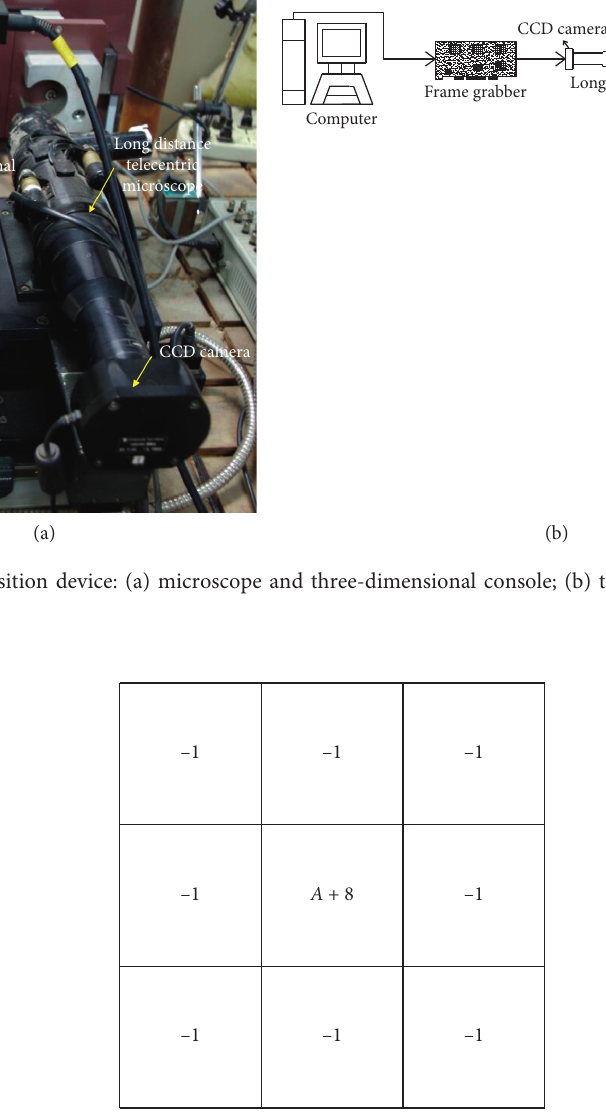
Figure 3: The Laplace transform composite